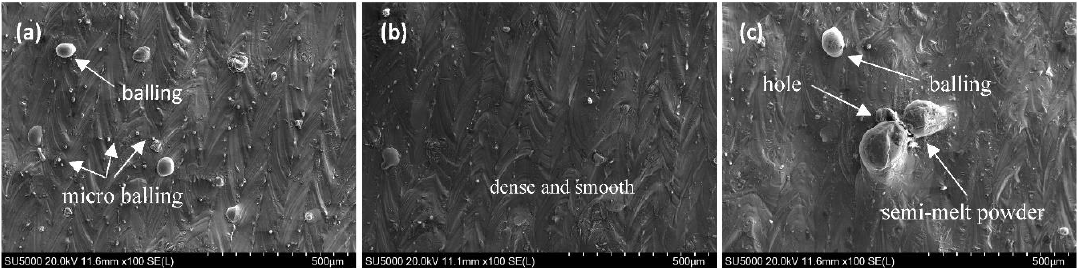
Figure 11. SEM images of the top surface morphologies of AlSi10Mg parts fabricated at different PD: ( a ) 60 μm; ( b ) 80 μm; and ( c ) 100 μm. The ET is fixed at 140 μs.